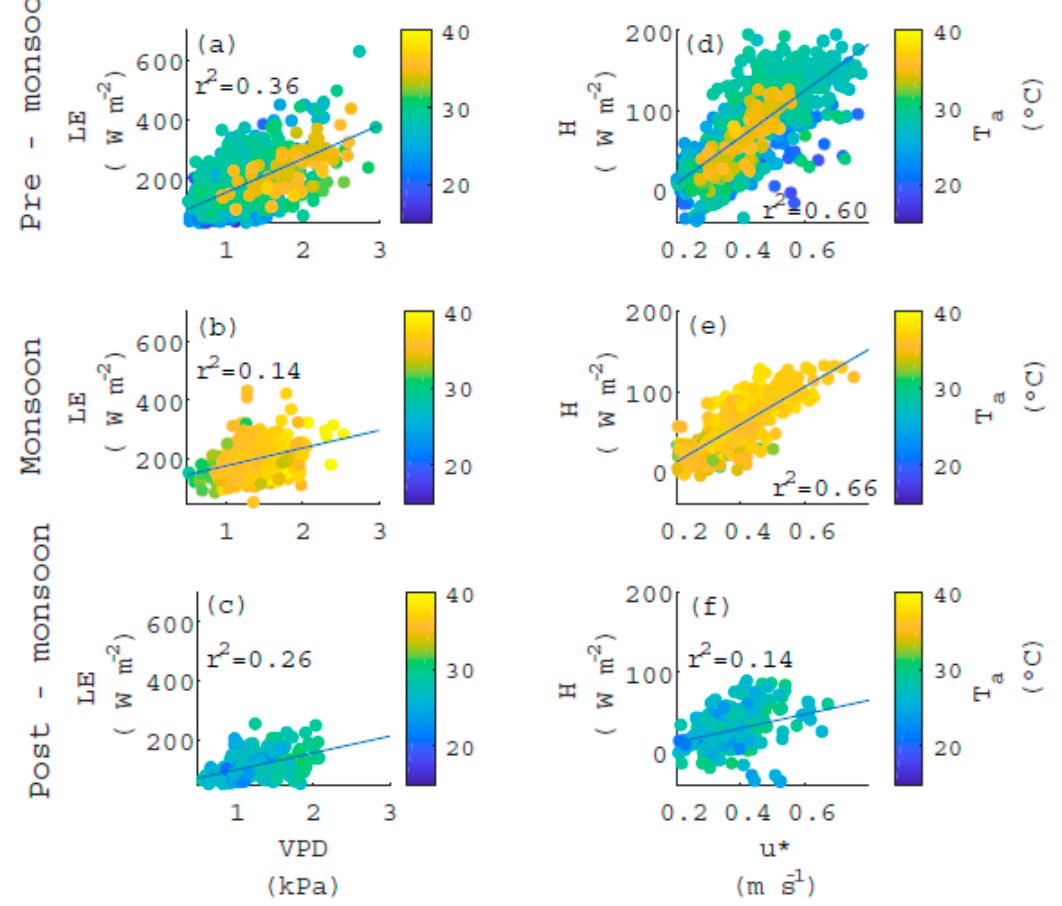
Figure 6. Ordinary linear regression of turbulent fluxes and micrometeorological variables: correlation of vapor pressure deficit (VPD, kPa) with latent heat (LE, W m − 2 ), and friction velocity ( u* , m s − 1 ) with sensible heat (H, W m − 2 ), considering air temperature T a , and seasonality: pre-monsoon ( a – d ), monsoon ( b – e ), post-monsoon ( c – f ). Data from 10 to 15 h were used.